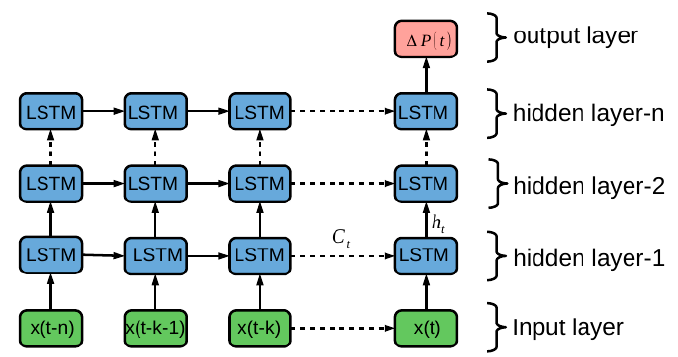
Figure 6. LSTM neural network.